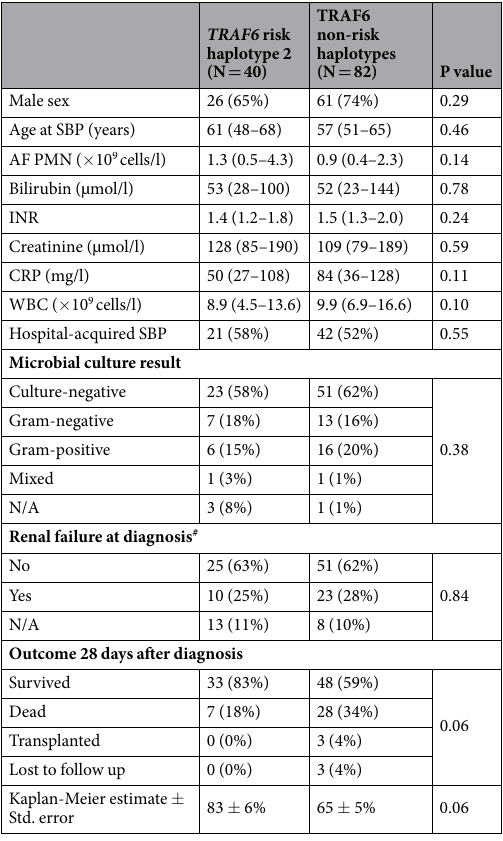
Table 3. Characteristics of the first episode of spontaneous bacterial peritonitis. Median/IQR or Frequency/ Percentage are shown; P values from Mann-Whitney U test, Fisher’s exact test or log-rank test as appropriate. # Kidney failure was defined by serum creatinine > 2 mg/dl or the need for renal replacement therapy according to acute-on-chronic liver failure criteria. Abbreviations: spontaneous bacterial peritonitis (SBP), ascitic fluid (AF), polymorphnuclear cells (PMN), international normalized ratio (INR), C-reactive protein (CRP), white- blood-cell (WBC), N/A: not available.